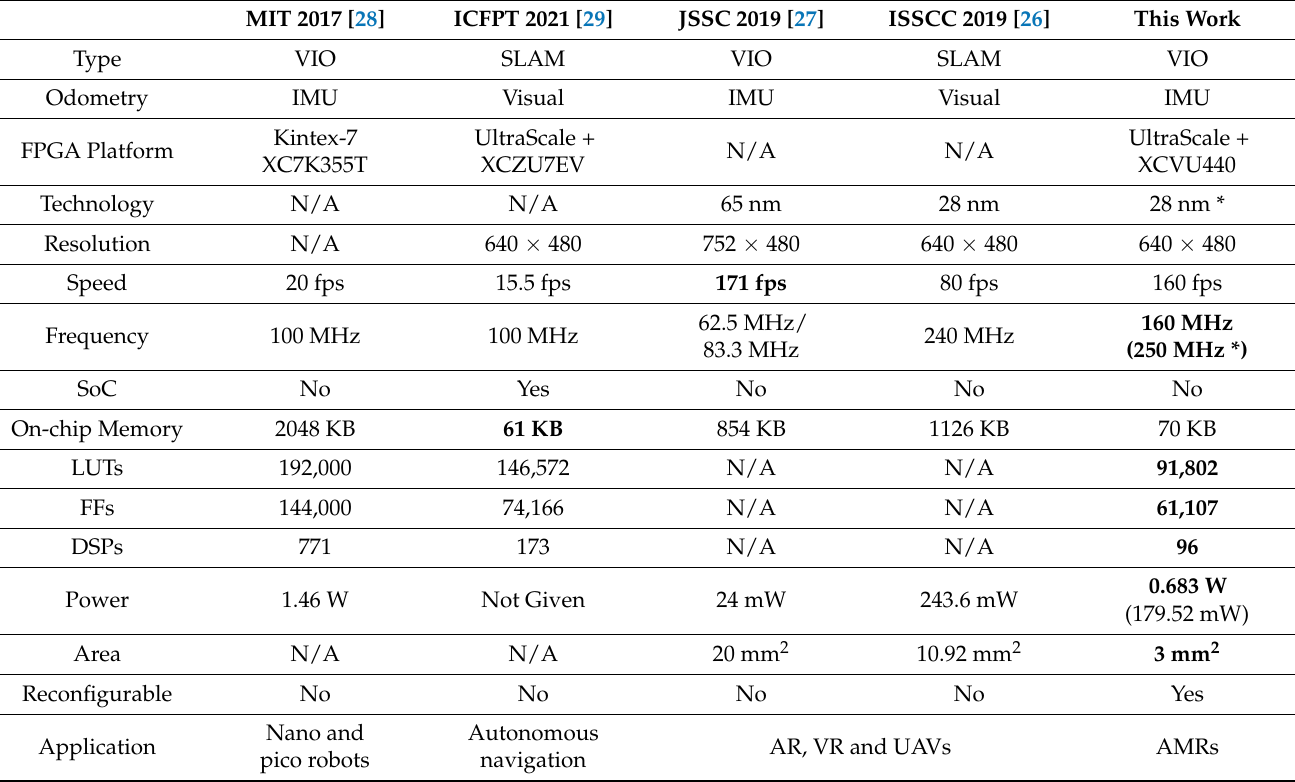
Figure 10. Demo evaluation platform. ( a ) VU440 FPGA board with mt9v034 image sensor and MPU9250 IMU. ( b ) New features are shown through the HDMI display. ( c ) Trajectory output in the x, y, and z axes (three dimensions). Table 4. Hardware implementation results. The outstanding work in the comparison is